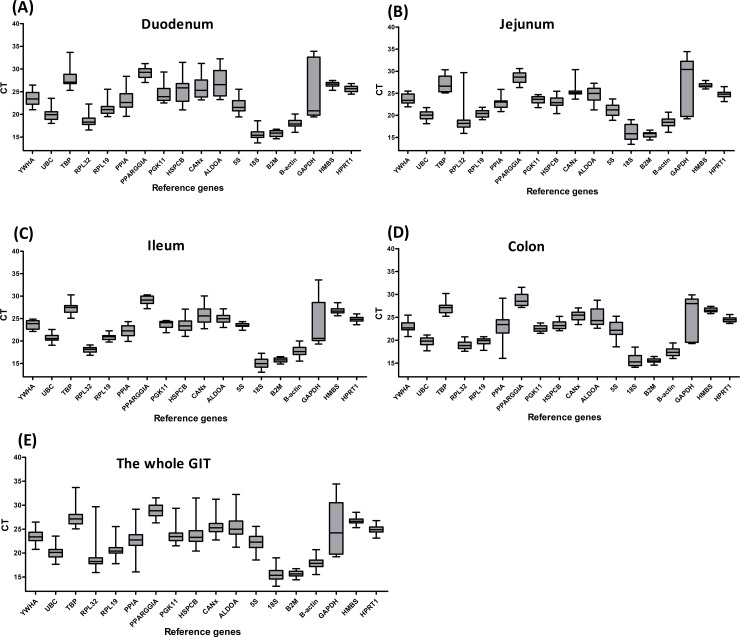
Distribution of the CT values of the reference genes in the duodenum (A), jejunum (B), ileum (C), colon (D) and whole gastrointestinal tract (E) of piglets. The boxes encompass the 25th to the 75th percentiles. The middle line in a box marks the median. Whisker caps indicate the minimum and maximum values.